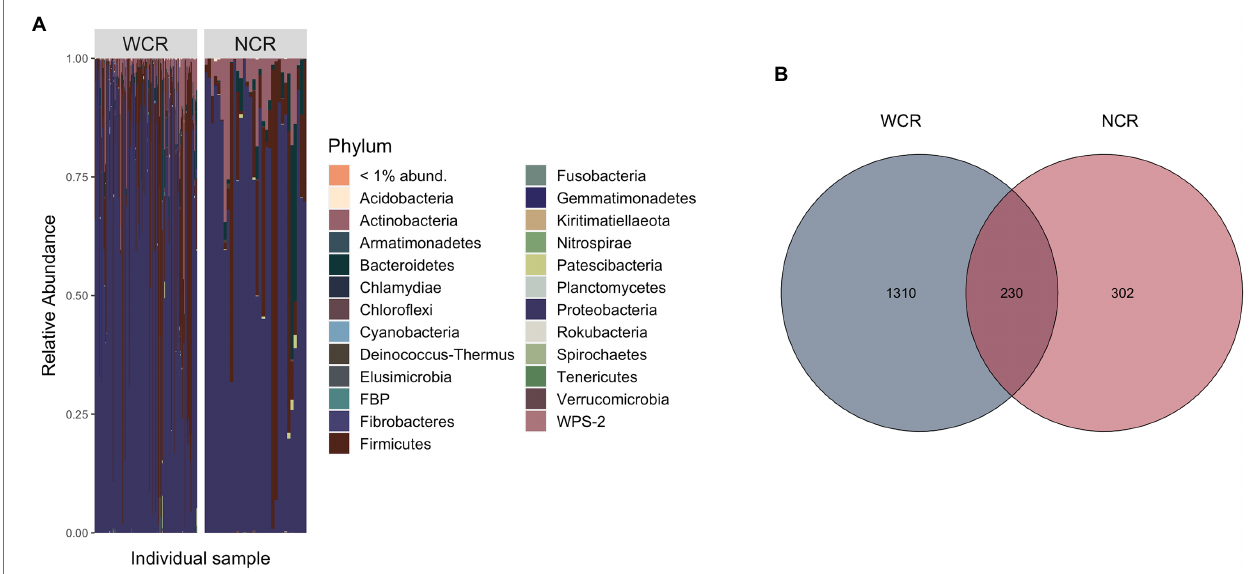
FIGURE 2 | (A) Phylum level stacked bar chart of average relative abundance of bacterial communities from adult Diabrotica virgifera virgifera (western corn rootworm, WCR) and Diabrotica barberi (northern corn rootworm, NCR) collected from across the United States arranged in order of decreasing longitude (west to east). Each bar represents an individual beetle. (B) Venn diagram comparing amplicon sequence variant (ASV) overlap in WCR and NCR microbiomes using rarefied data. Data presented with Wolbachia removed from communities.